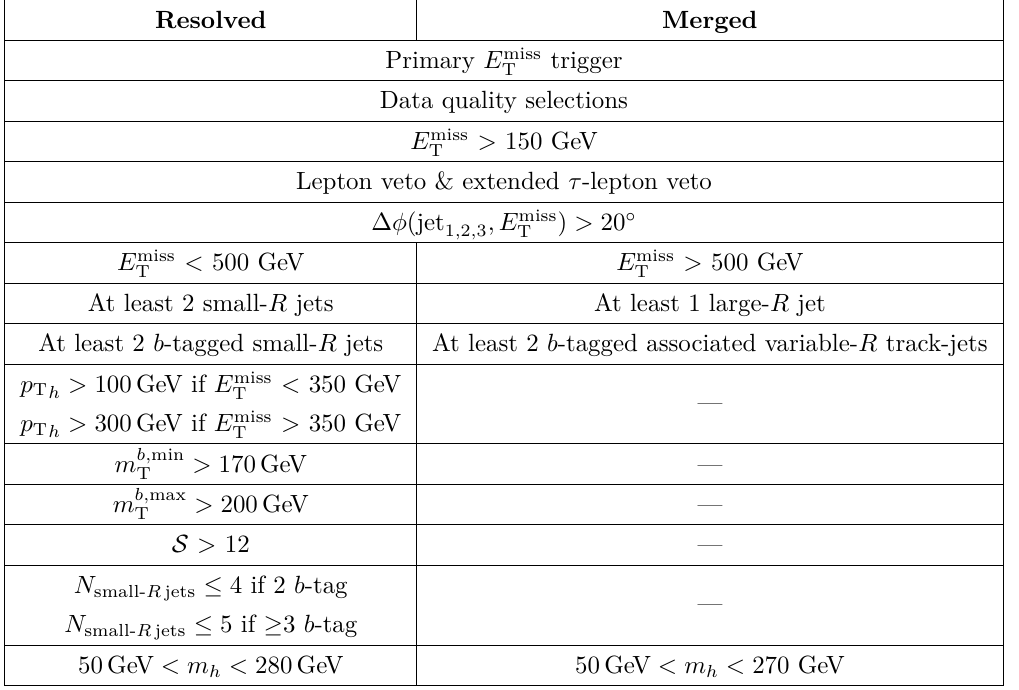
Summary of selections used to define the signal regions used in the analysis. The kinematic variables are defined in the